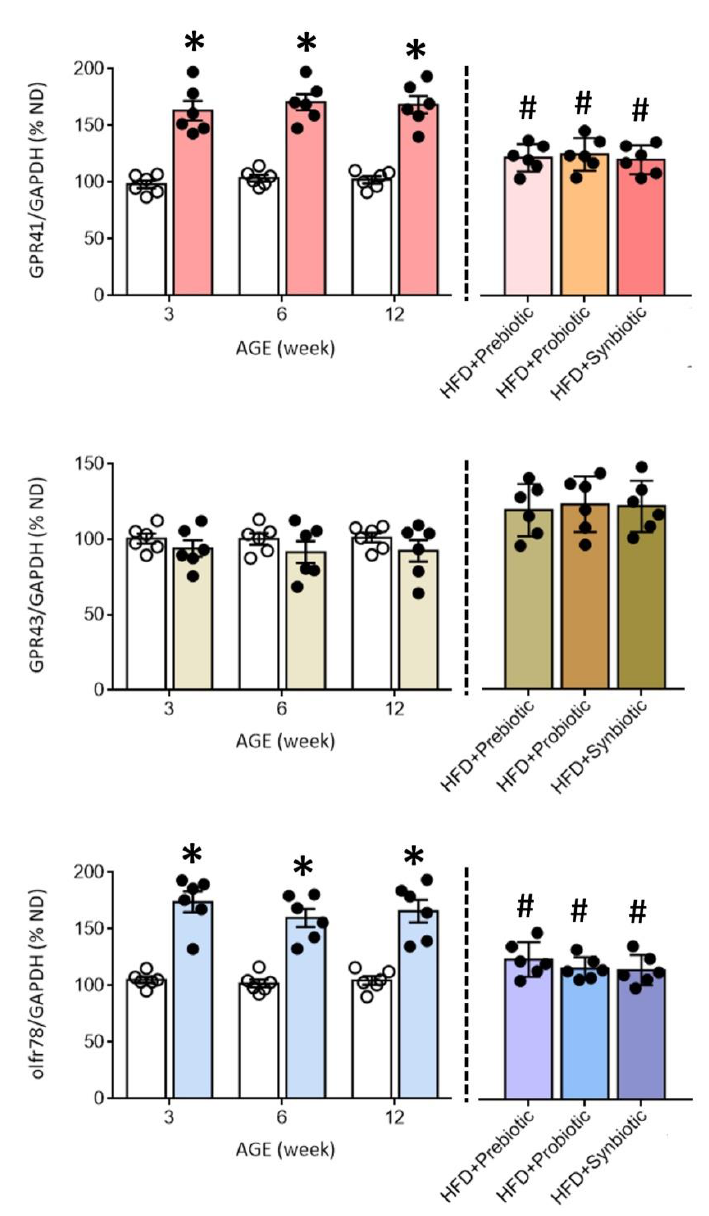
Figure 4. Percentage change in the expression of GPR41, GPR43, and olfr78 mRNA in the PVN of ND (open circles) or HFD (filled circles) offspring at the age of 3, 6, and 12 weeks or at 12 weeks after additional oral supplementation of FOS (4 g/kg/day, probiotic), L. gasseri (3 × 10 6 CFU/mL/day, probiotic) or FOS+ L. gasseri (synbiotic) was initiated at the age of 6 weeks. Data are presented as mean ± SD, n = 6 in each group. * p < 0.05 vs. ND group, and # p < 0.05 vs. HFD group in the post hoc Tukey’s multiple-range test.